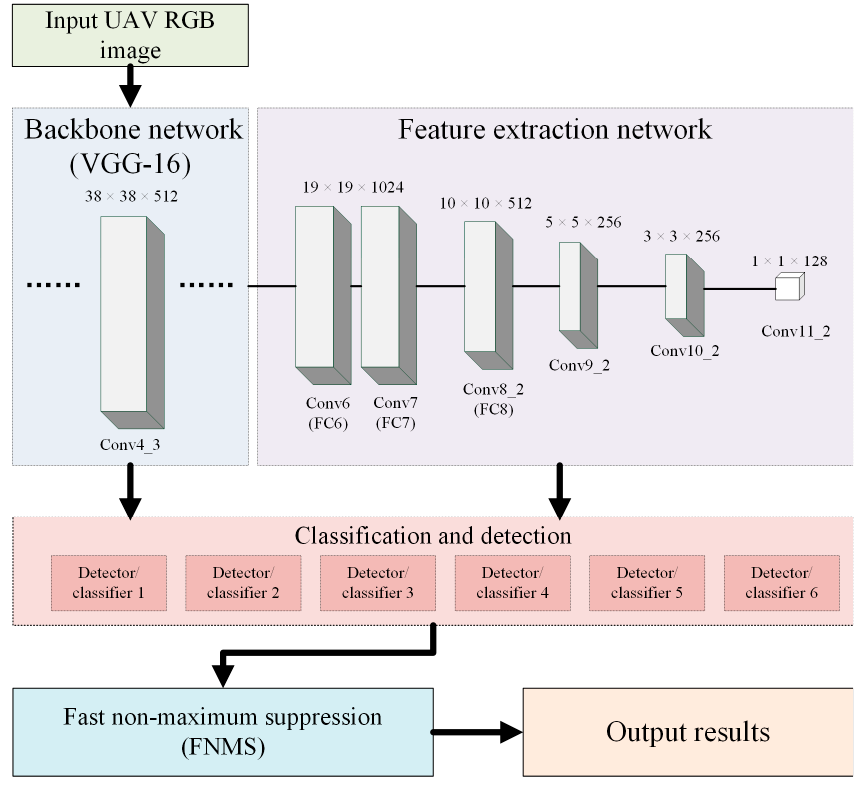
Figure 4. Architecture of SSD proposed by Liu et al.